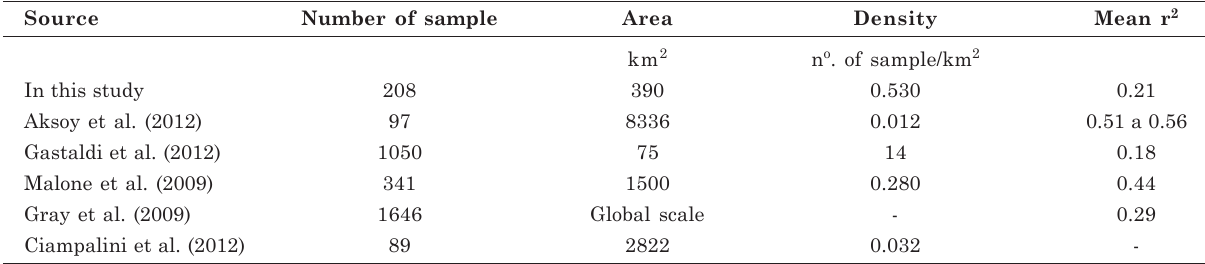
Table 7. Soil sampling density and mean r 2 of some